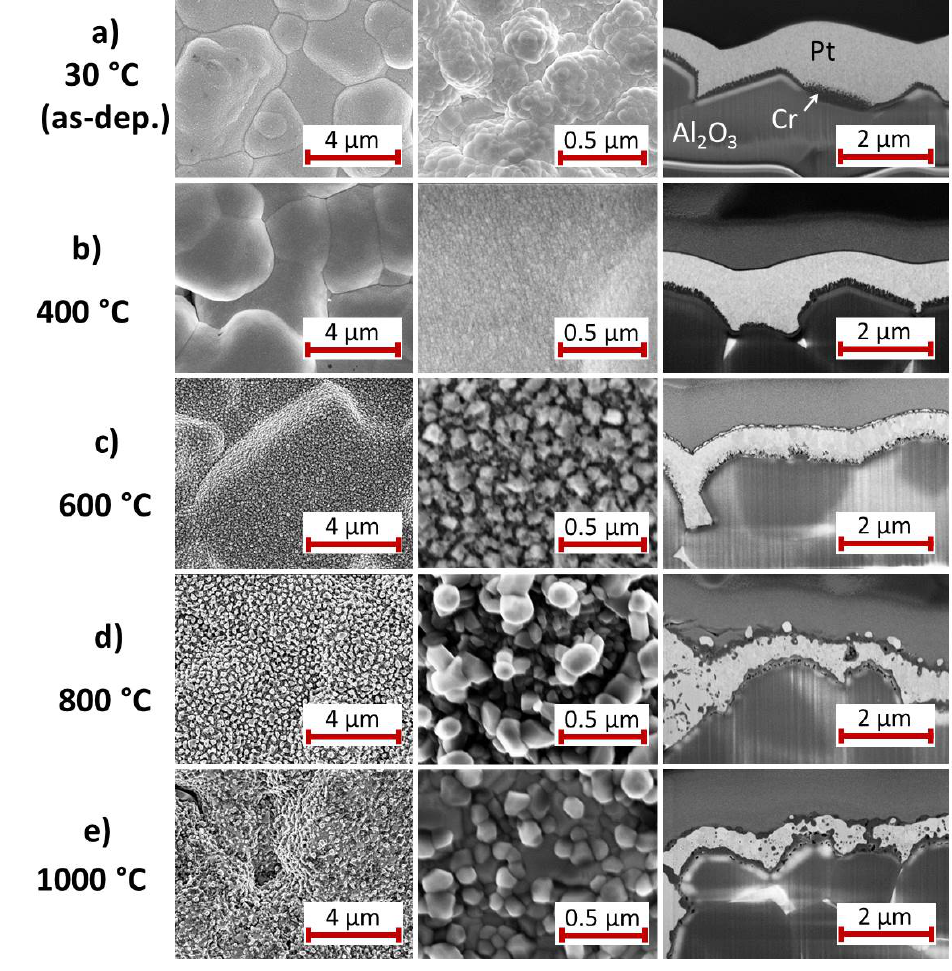
Figure 9. SEM images (InLens, 5 kV, 3 mm working distance) with two different magnifications of the surface of the Pt ∗ film on Cr seed layer ( a ) after deposition and after annealing for 2 h in air at ( b ) 400; ( c ) 600; ( d ) 800 and ( e ) 1000 ◦ C. On the right hand side a SEM image (InLens, 3 kV, 5 mm working distance) of the film cross-section is